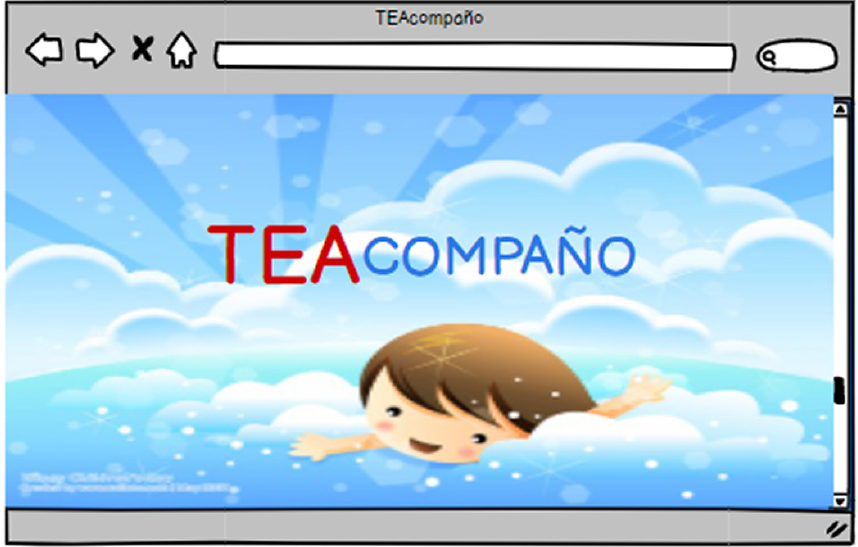
Fig. 2. Main screen of the educational platform